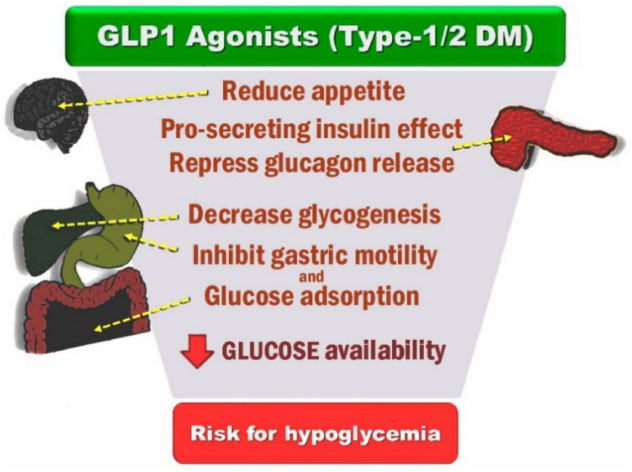
Figure 2. Glucagon-like peptide-1 (GLP-1) receptor agonists, also called incretin mimetics, are agonists of the Glucagon-like peptide 1 receptor that increase insulin secretion, inhibit glucagon release and improve serum levels of